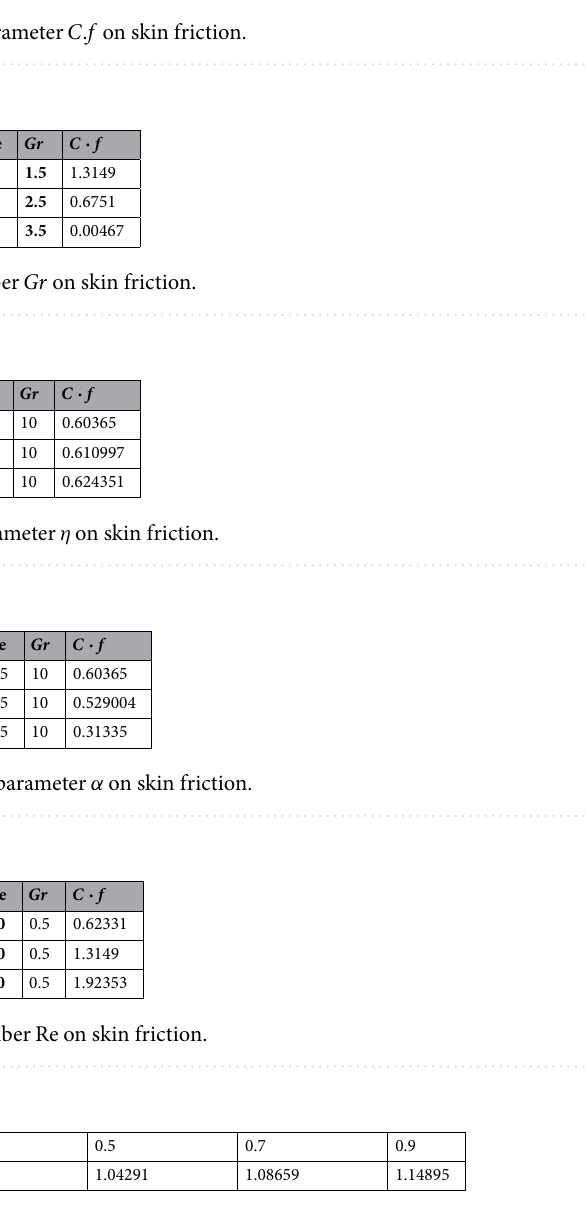
Table 8. Variation in Nusselt number with radiation parameter N